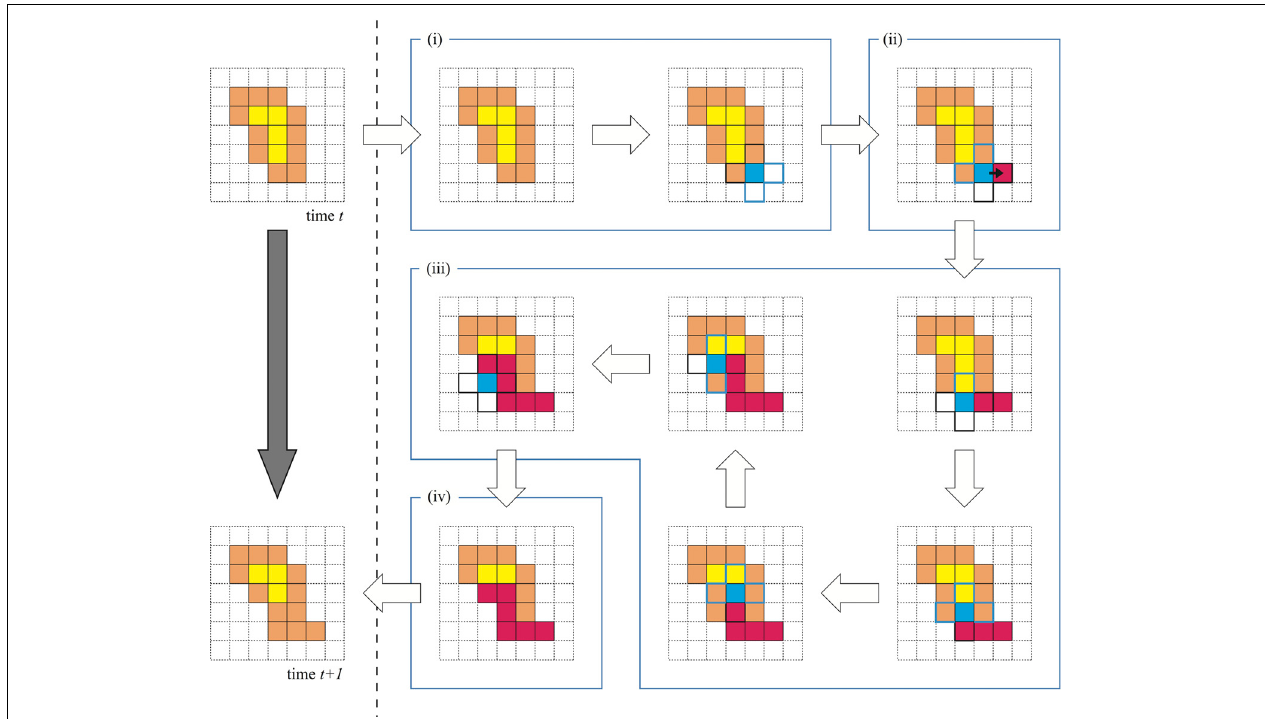
FIGURE 1 | Basicalgorithmofthemodel. Theleftcolumnindicatesthetimeevolutionofthemodelfromtime t to t + 1.Theright-handportionindicatesthefour